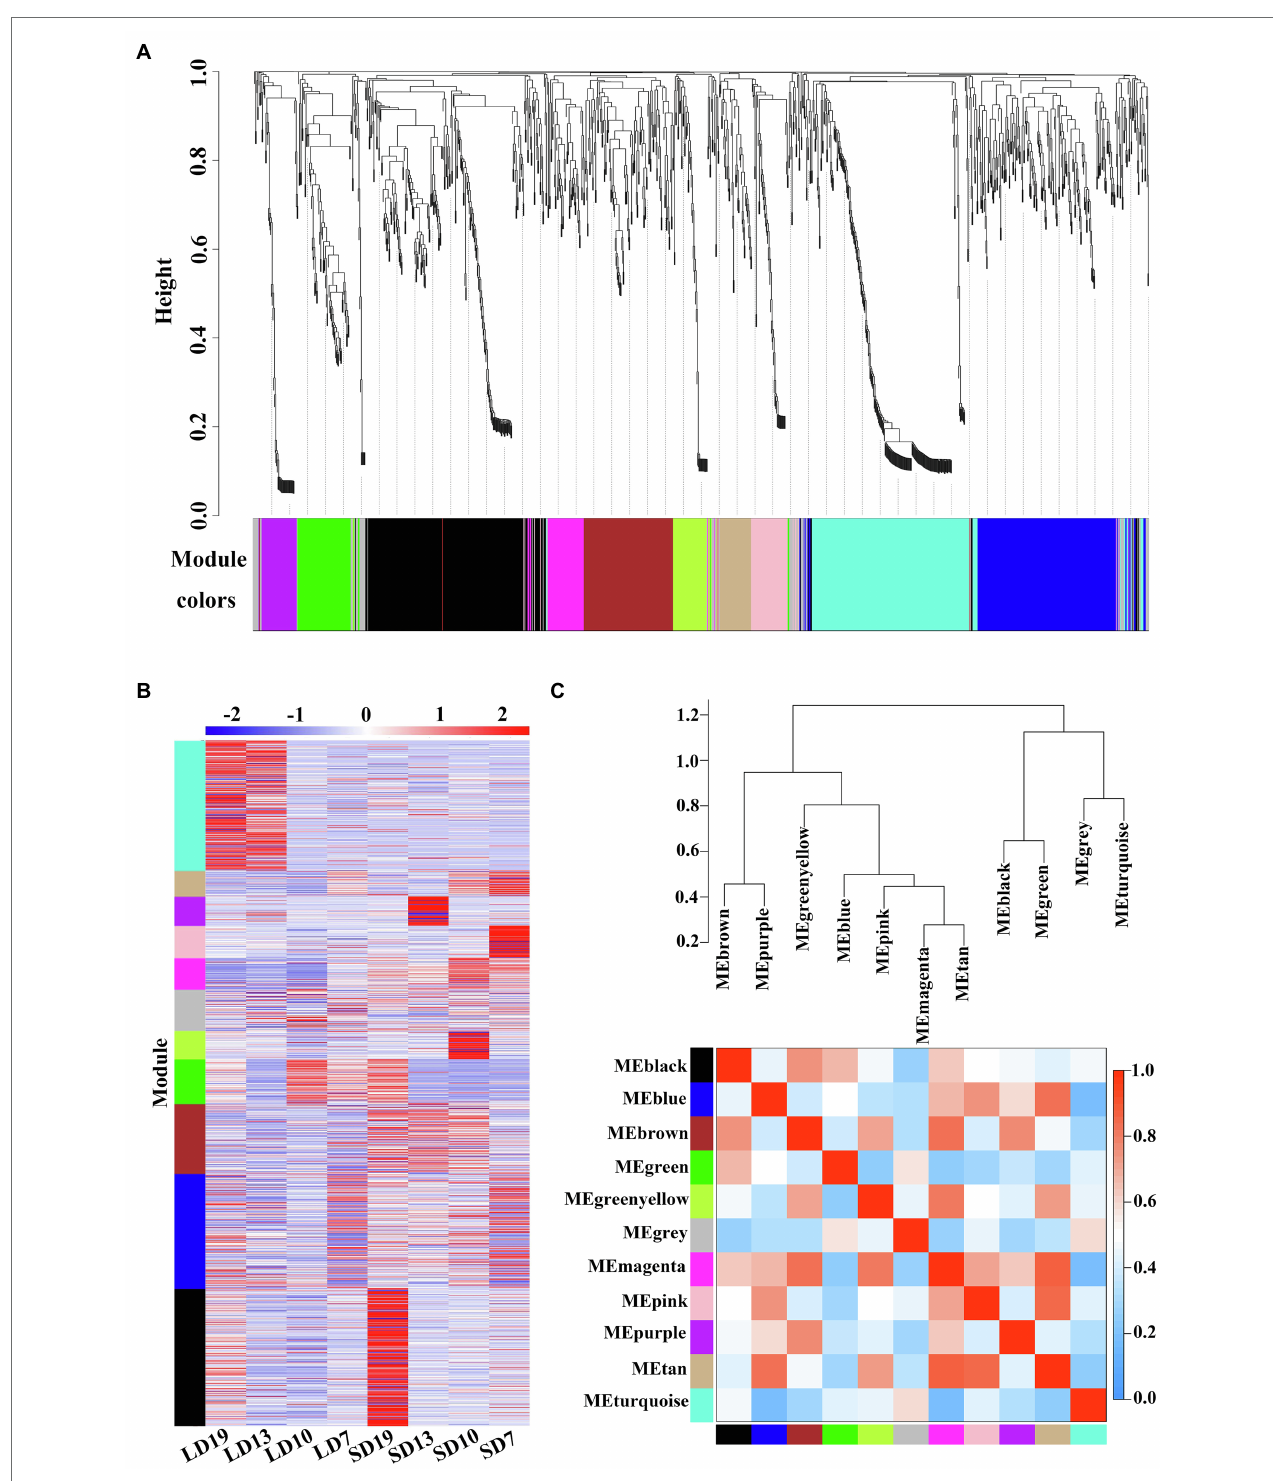
FIGURE 4 | Weighted co-expression network analysis of 1,226 DEGs at four developmental stages of L. gratissima, short- or long-day treatments. (A) Hierarchical cluster tree showing the co-expression modules, with each tree leaf representing one gene. The major tree branches constitute 11 modules labeled by different colors. (B) Heat map of gene relative expression of different modules (y-axis) in eight samples (x-axis). The Z-score normalized RPKM value for an individual gene at a given developmental stage is indicated in a green (low expression) to red (high expression) scale. (C) Eigengene network representing the relationships among the different modules. The hierarchical clustering dendrogram of the eigengenes shows the relationships among the modules, whereas the heat map shows the correlation between the different modules, with deeper red color representing a stronger